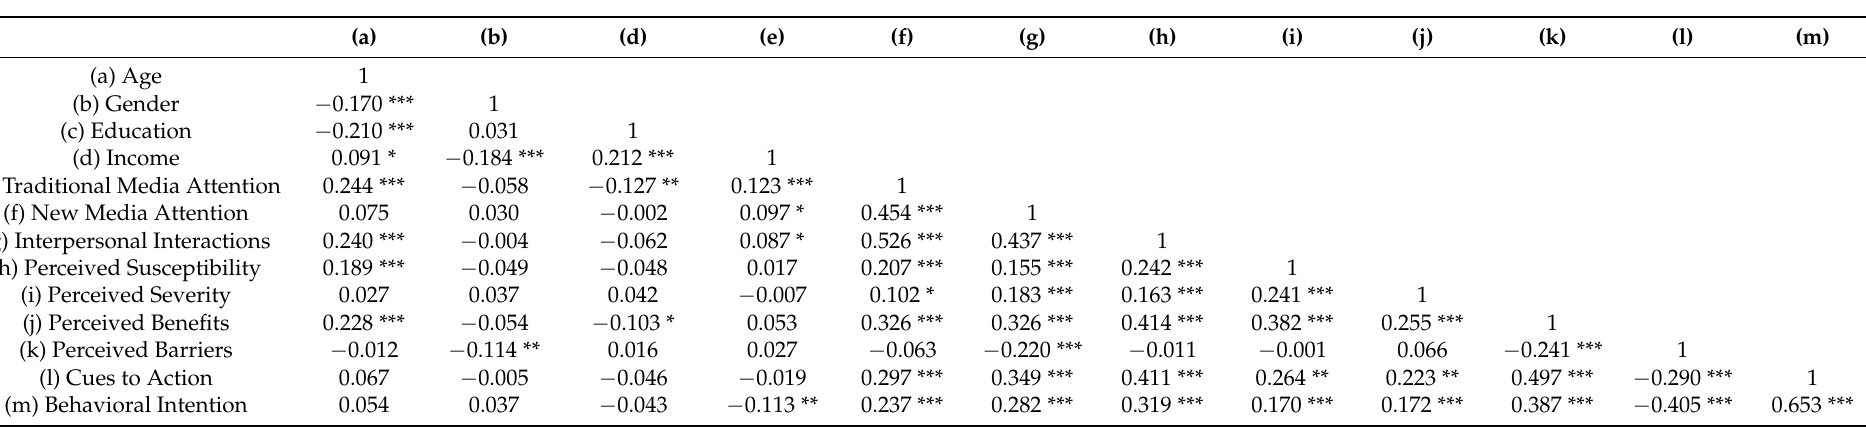
Table 2. Bivariate correlations among all variables ( n = 621